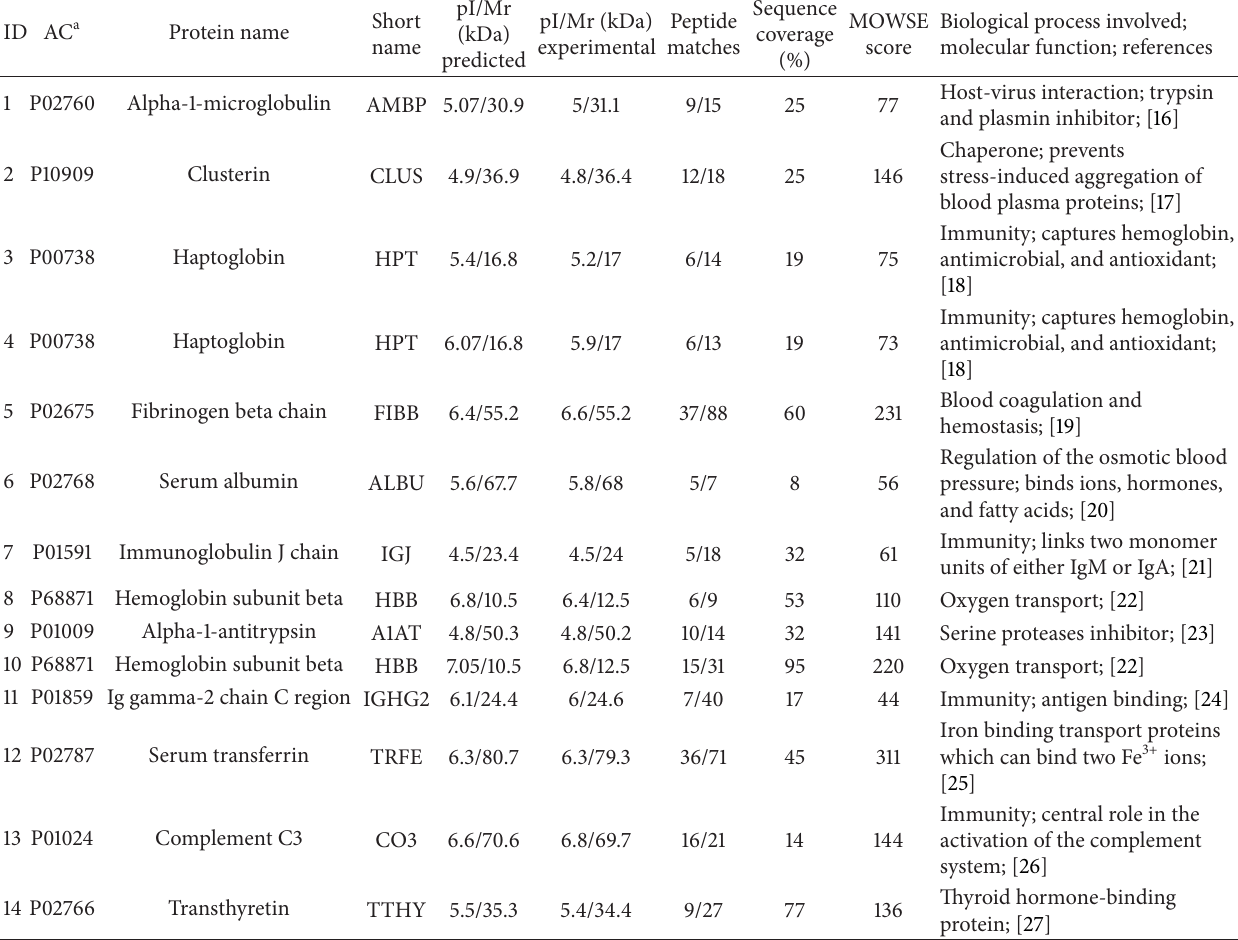
Table 1: Identification of plasma proteins in RTT patients and healthy controls by